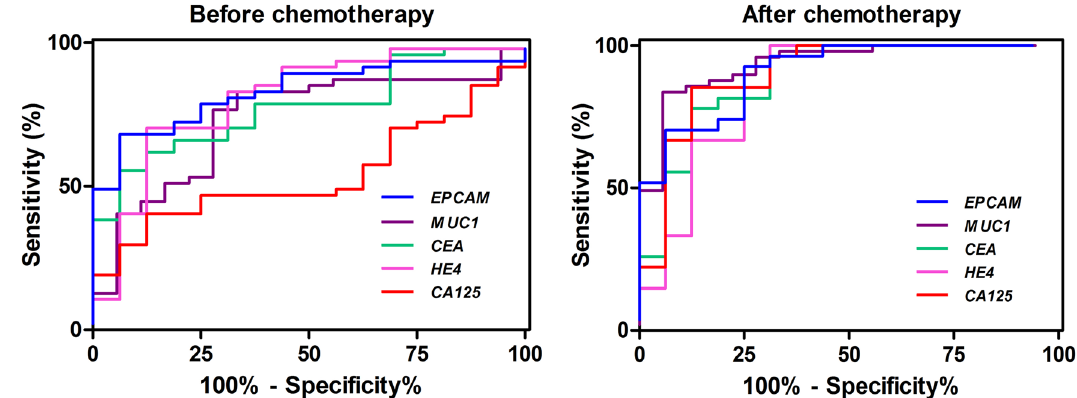
Figure 3. Receiver operating characteristic (ROC) curves for EPCAM , MUC1 , CEA , HE4 and CA125 mRNA markers before and after